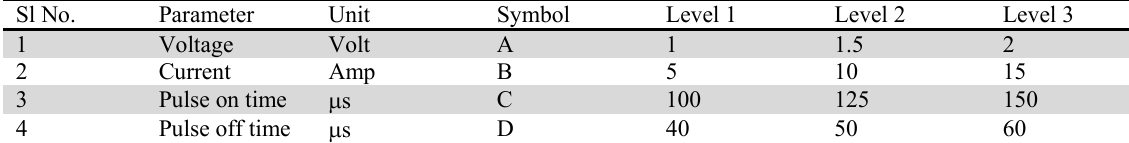
Process parameters and their levels Sl